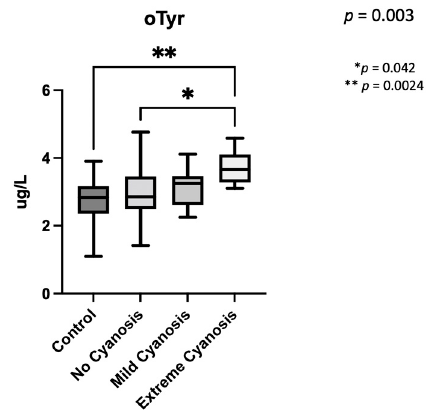
Figure 5. Ortho-Tyrosine levels depending on expected cyanosis after birth. The global p of the analysis was p = 0.003. (*) remarks the p obtained in the post-hoc analysis when controls and extreme- cyanosis patients were compared, and (**) is used to indicate p -value for the statistical differences between extreme-cyanosis and no cyanosis. o-Tyr: ortho-Tyrosine.